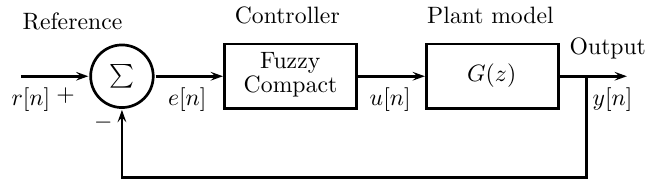
Figure 4. General diagram of the control